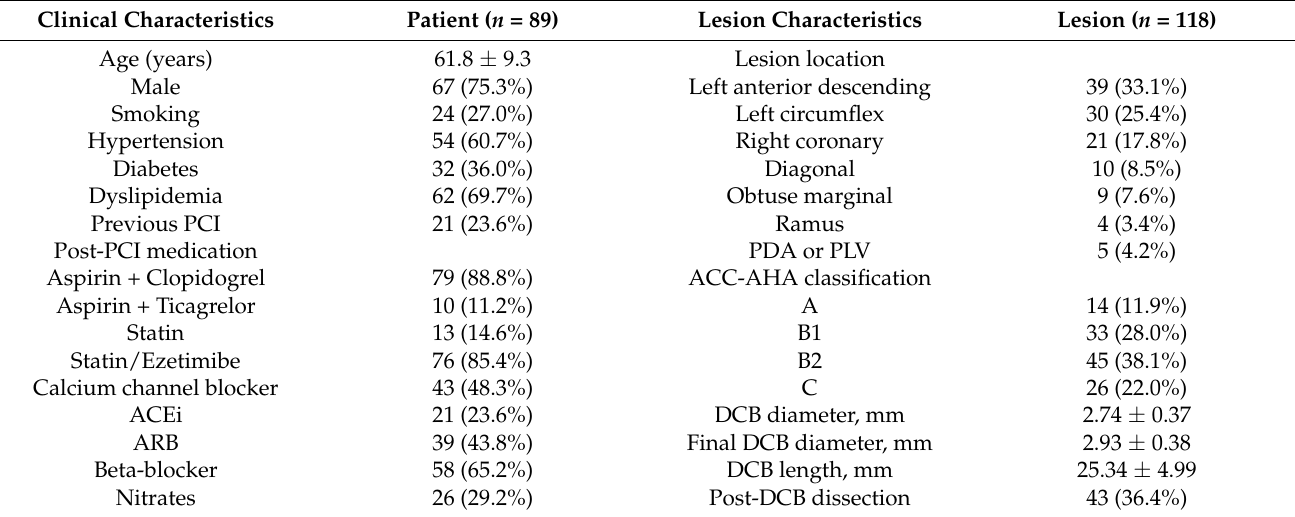
Table 1. Clinical, lesional, and procedural characteristics of 89 patients who underwent the provoca- tion test.